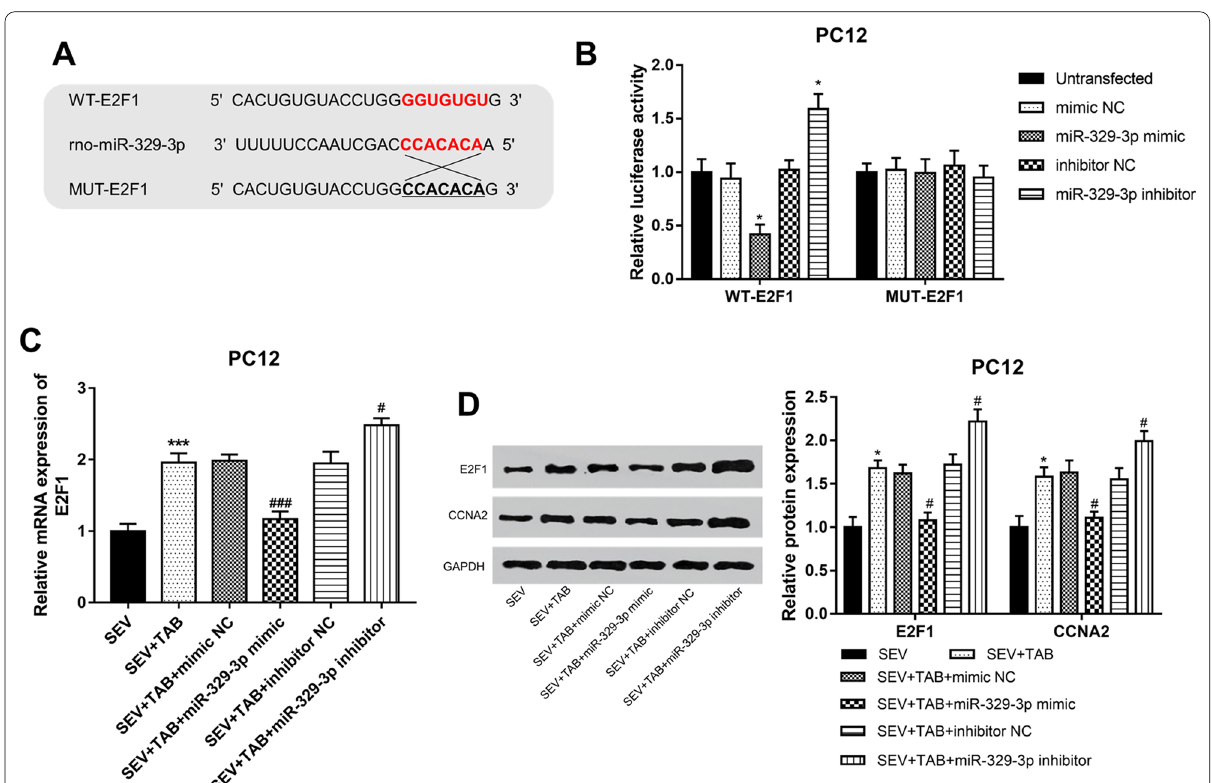
Fig. 6 miR-329-3p directly targeted E2F1 and inhibited theE2F1/CCNA2 pathway in PC12 cells. A The complementary sequence of miR-329-3pat the 3’-UTR of E2F1. B miR-329-3p significantly inhibited the relativeluciferase activity in PC12 cells with WT-E2F1 (* P < 0.05). C E2F1 mRNA expression was enhanced by TAB in PC12cells exposed to sevoflurane, and this effect was further enhanced bymiR-329-3p inhibition, but was weakened by miR-329-3p overexpression (*** P < 0.05 compared to SEV; # P <0.05, ### P < 0.001 compared to SEV TAB). D miR-329-3p overexpression significantly + inhibited the protein expression ofE2F1 and CCNA2, while miR-329-3p reduction led to the opposite effects on E2F1and CCNA2 protein expression (* P <0.05 compared to SEV; # P <0.05 compared to SEV +